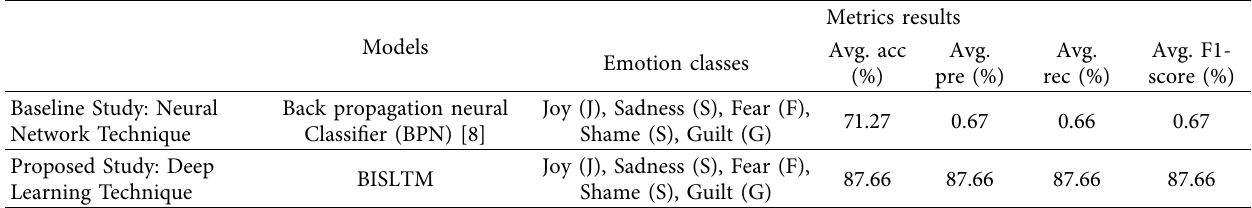
Table 6: Comparative results of the proposed method with the baseline studies for emotion classification.